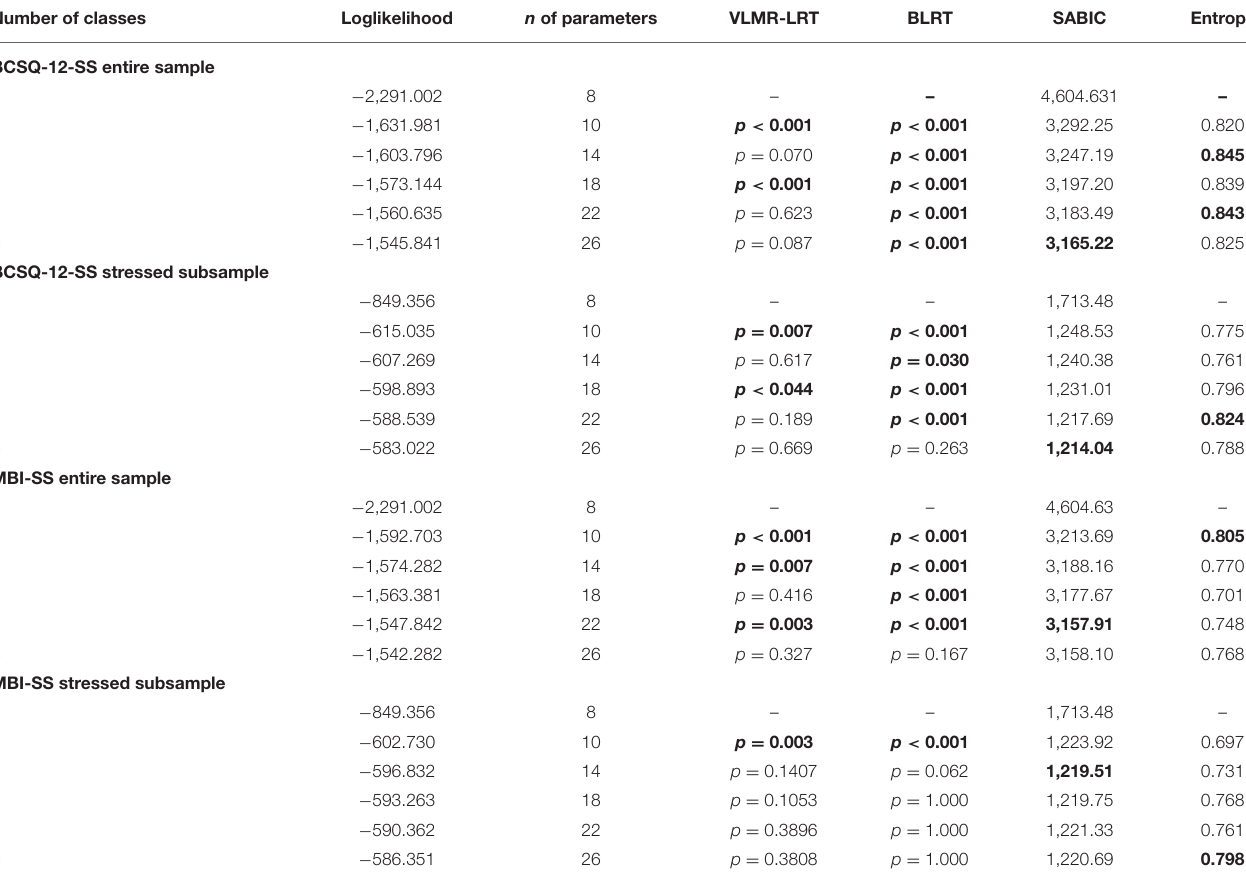
TABLE 4 | Fit statistics of the LPA with the BCSQ-12-SS/MBI-SS in the entire sample and in the stressed subsample. Number of classes Loglikelihood n of parameters VLMR-LRT BLRT SABIC